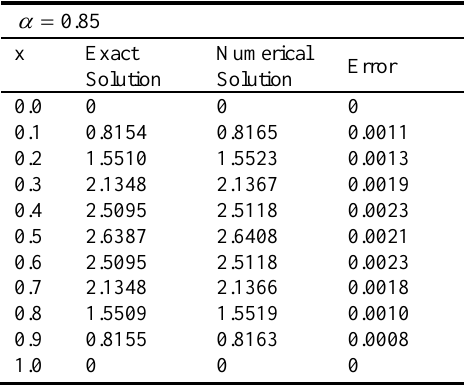
Table 1. Numerical results